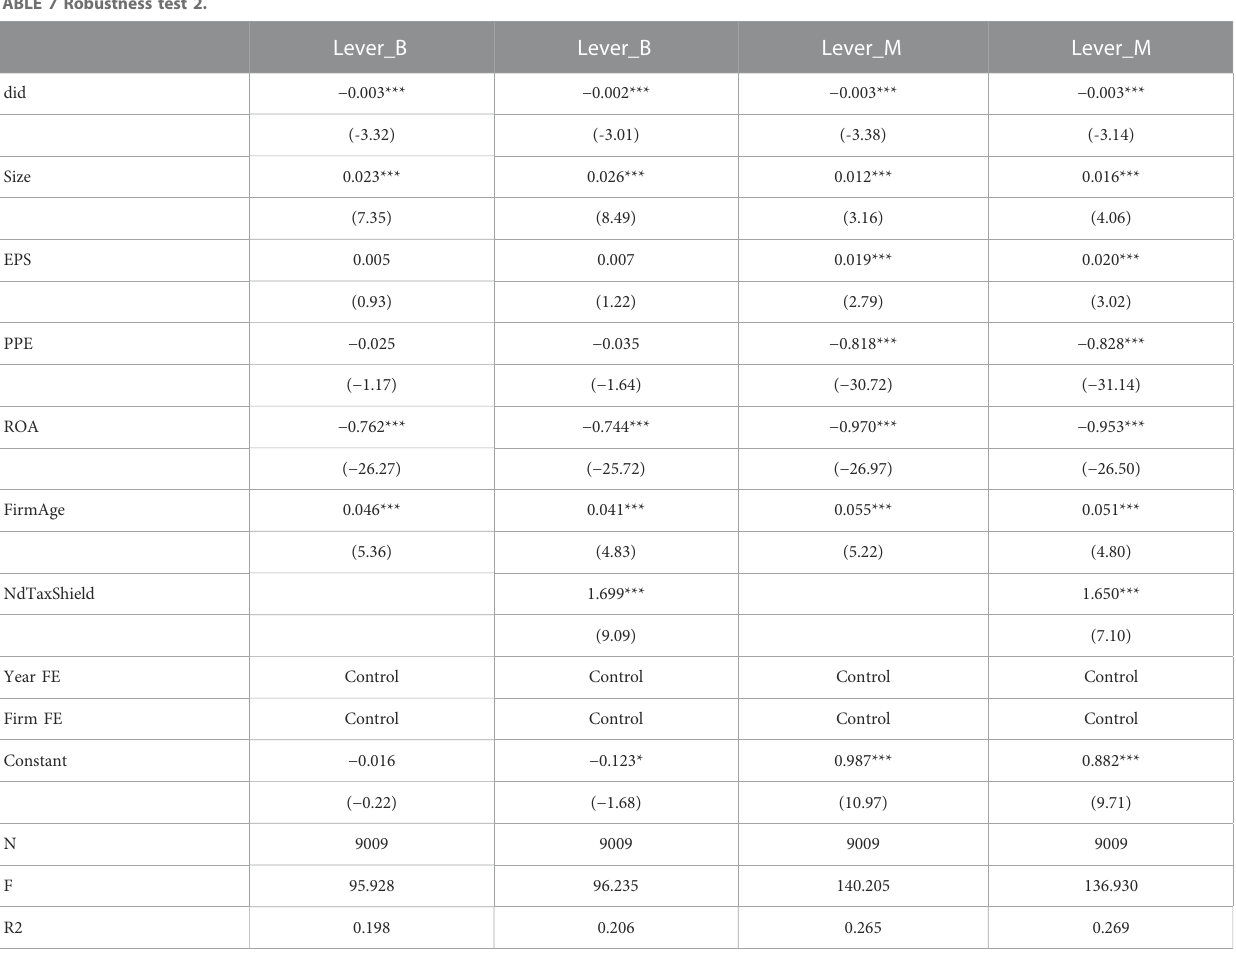
TABLE 7 Robustness test